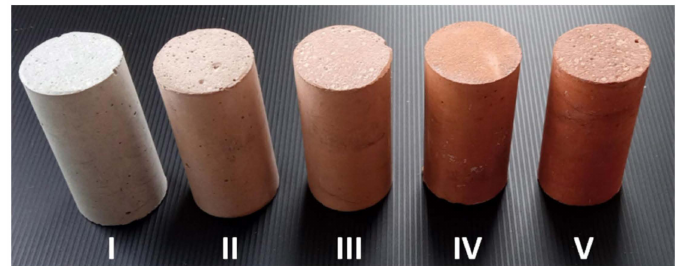
Figure 8. Representative photographs of the alkali activated binders produced with the progressive replacement of MK by CRC. From left to right: (i) 0.0%, (ii) 25.0%, (iii) 50.0%, (iv) 75.0%, and (v) 100.0% MK replacement.